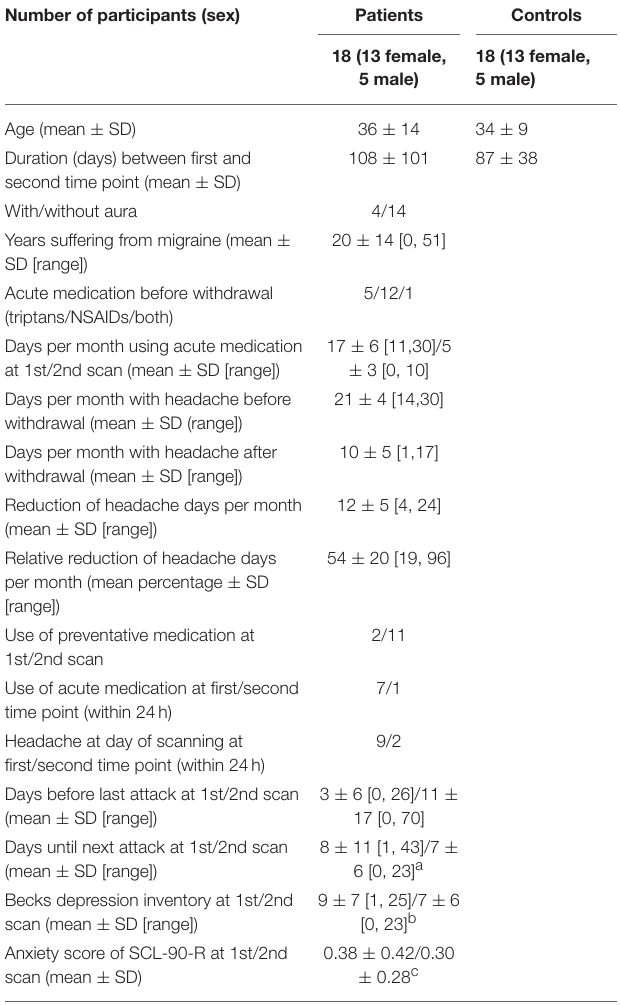
TABLE 1 | Clinical characteristics of